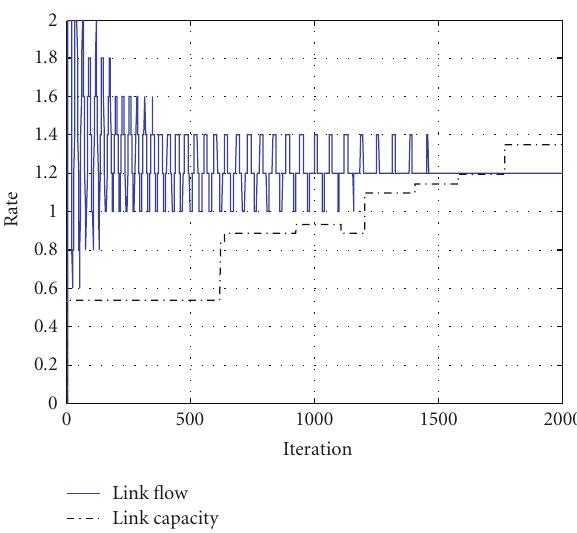
Figure 5: The flow and capacity of links 7, 8, and 9.